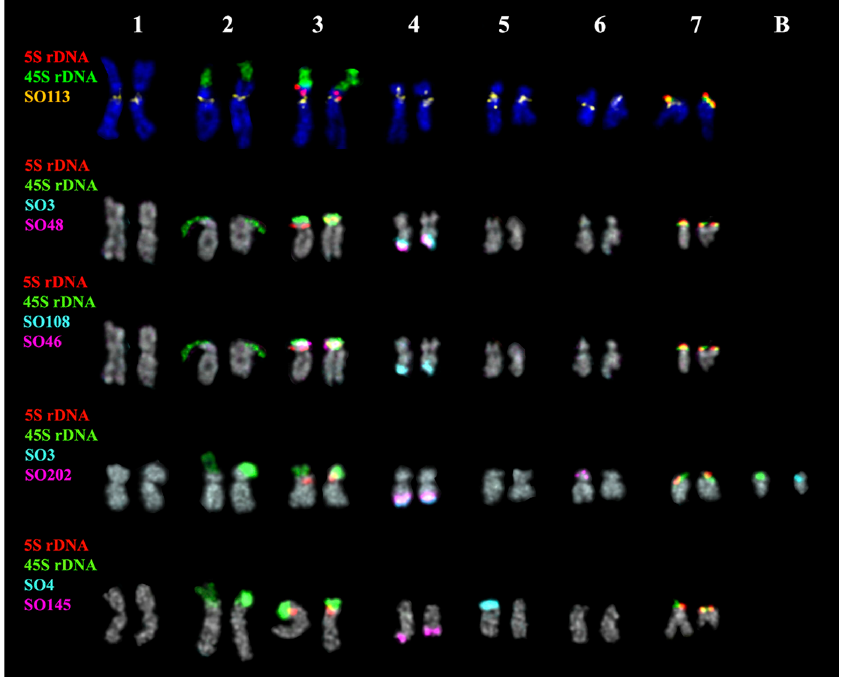
Figure 4. Karyograms of Salvia officinalis after multicolor FISH with 45S rDNA (green), 5S rDNA (red), SO113 (yellow), SO3, SO4, and SO108 (aqua), and also SO48, SO46, SO202, and SO145 (purple) (the same metaphase plates as in Figures 2D and 3A–D). Chromosome pair numbers—1–7. B–B